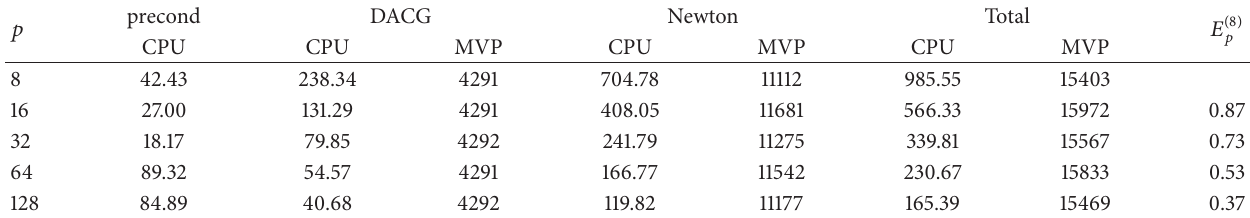
Table 6: Iterations, timings, and pseudo efficiencies for problem FLOW3D-663 .